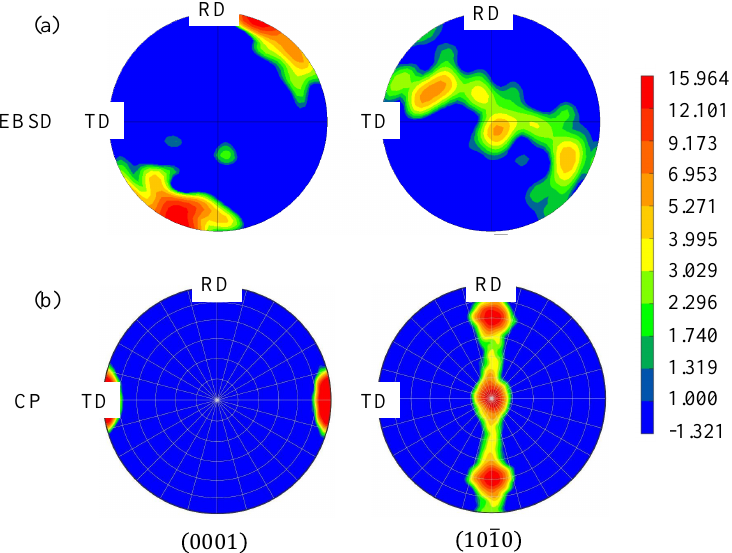
Figure 1. Generation of statistically equivalent orientation distribution function. ( a ) Typical measured texture in MTR in related alloy Ti–6Al–4V [21], with permission from author, 2009; ( b ) model input texture (primary orientation depends on parent MTR). In the current figure and the pole figures that follow, the color map denotes the texture component strength times